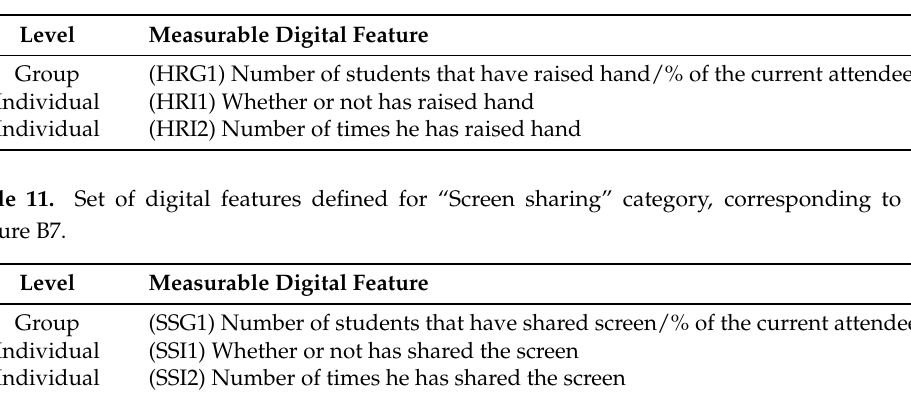
Table 10. Set of digital features defined for “Hand rising” category, corresponding to the feature B5.